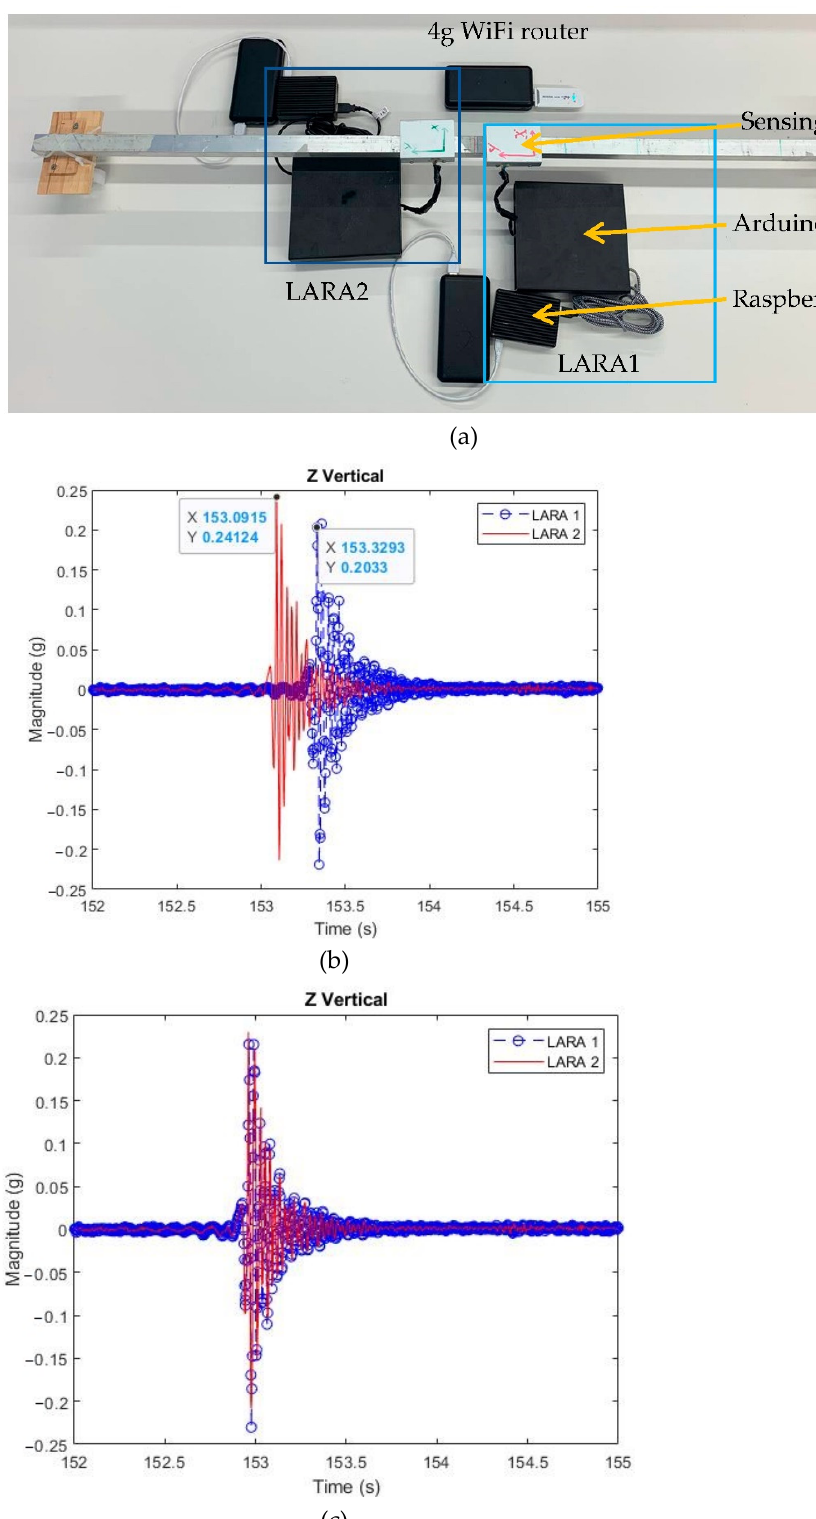
Figure 3. Synchronization experiment: ( a ) setup of two LARAs on a simply supported beam, ( b ) time domain vibration presentation of two LARAs with the same initiation time, and ( c ) time domain vibration presentation of two LARAs with the same initiation time and resampled acquired vibrations.